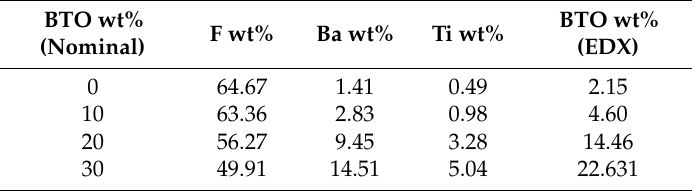
Table 1. BTO content of the PVDF–BTO composites obtained from their energy-dispersive X-ray (EDX) spectra. BTO